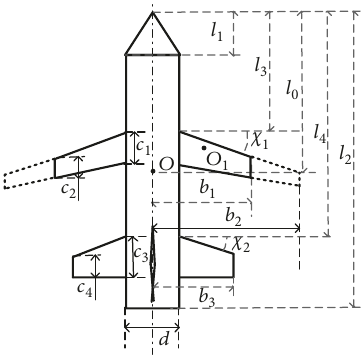
Figure 2: The shape parameters and morphing modes of the hypersonic morphing missile.